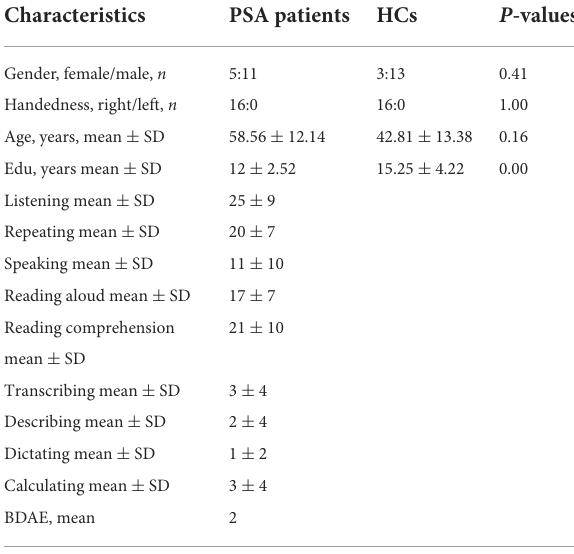
TABLE 1 Demographic data and clinical characteristics of the PSA and HCs groups.